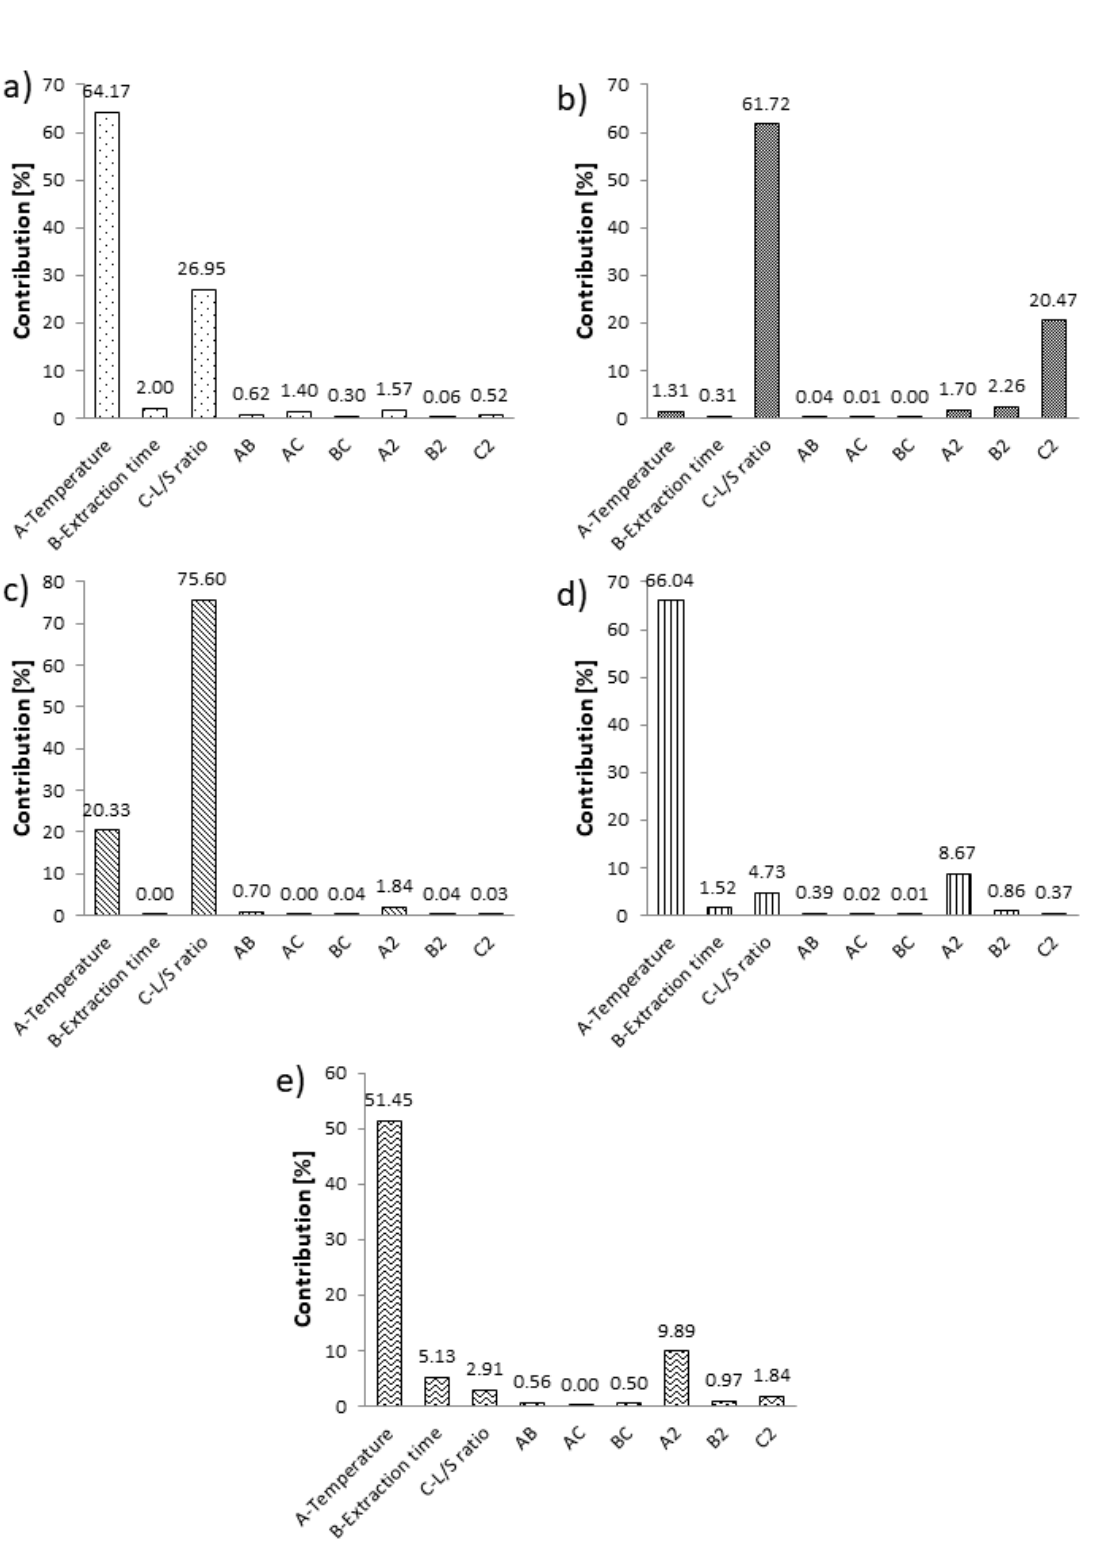
Figure 3. Contribution plots for the linear, interaction and quadratic terms on ( a ) TP, ( b ) TF, ( c ) DPPH, ( d ) FRAP and ( e ) ABTS.